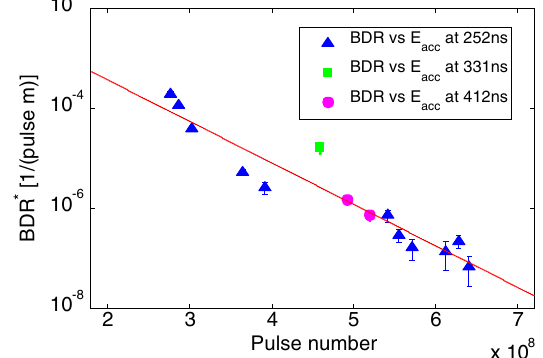
FIG. 7. BDR versus E measured at different rf-on times and acc pulse widths. The numbers beside the symbols are the integrated operation period in hours since the beginning of the conditioning process until the time of the BDR measurement.